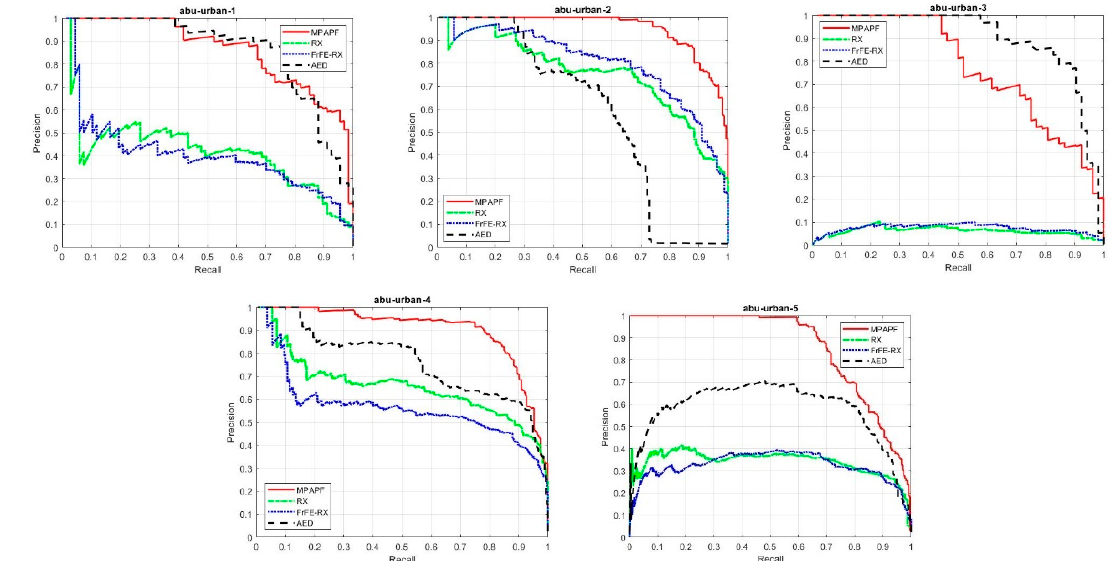
Figure 12. Precision-recall curves of the compared methods on the ABU-Urban Scene. Table 3. AUC values of precision-recall curves for the compared methods on the ABU datasets.